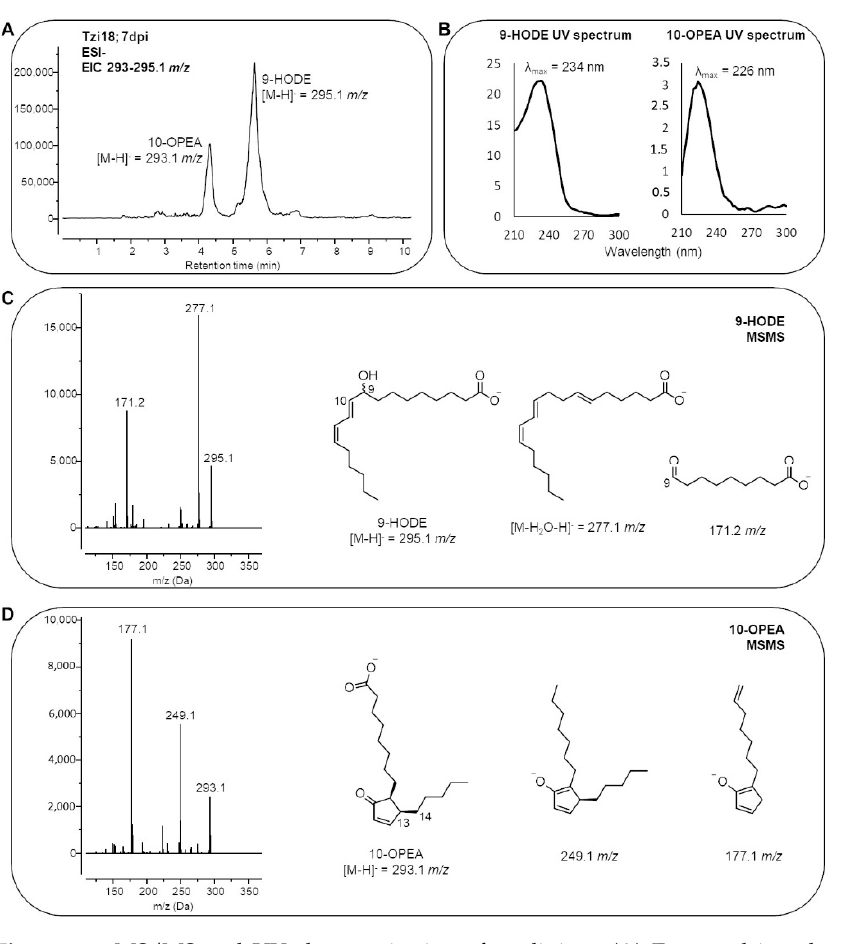
Figure 10. MS/MS and UV characterisation of oxylipins. ( A ) Extracted ion chromatogram of 293–295.1 m / z of Tzi18 at 7 dpi. ( B ) UV spectra of 9-HODE and 10-OPEA. ( C , D ) MS/MS fragmentation of 9-HODE and 10-OPEA. The structure of diagnostic daughter ions are reported.